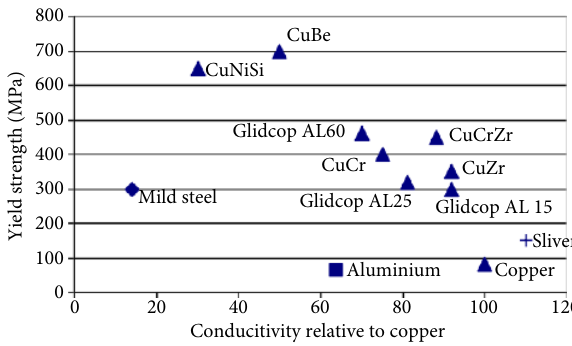
Fig. 4 Characteristics of different conductive materials (reprinted with per- mission from Ref. [42], © 2013